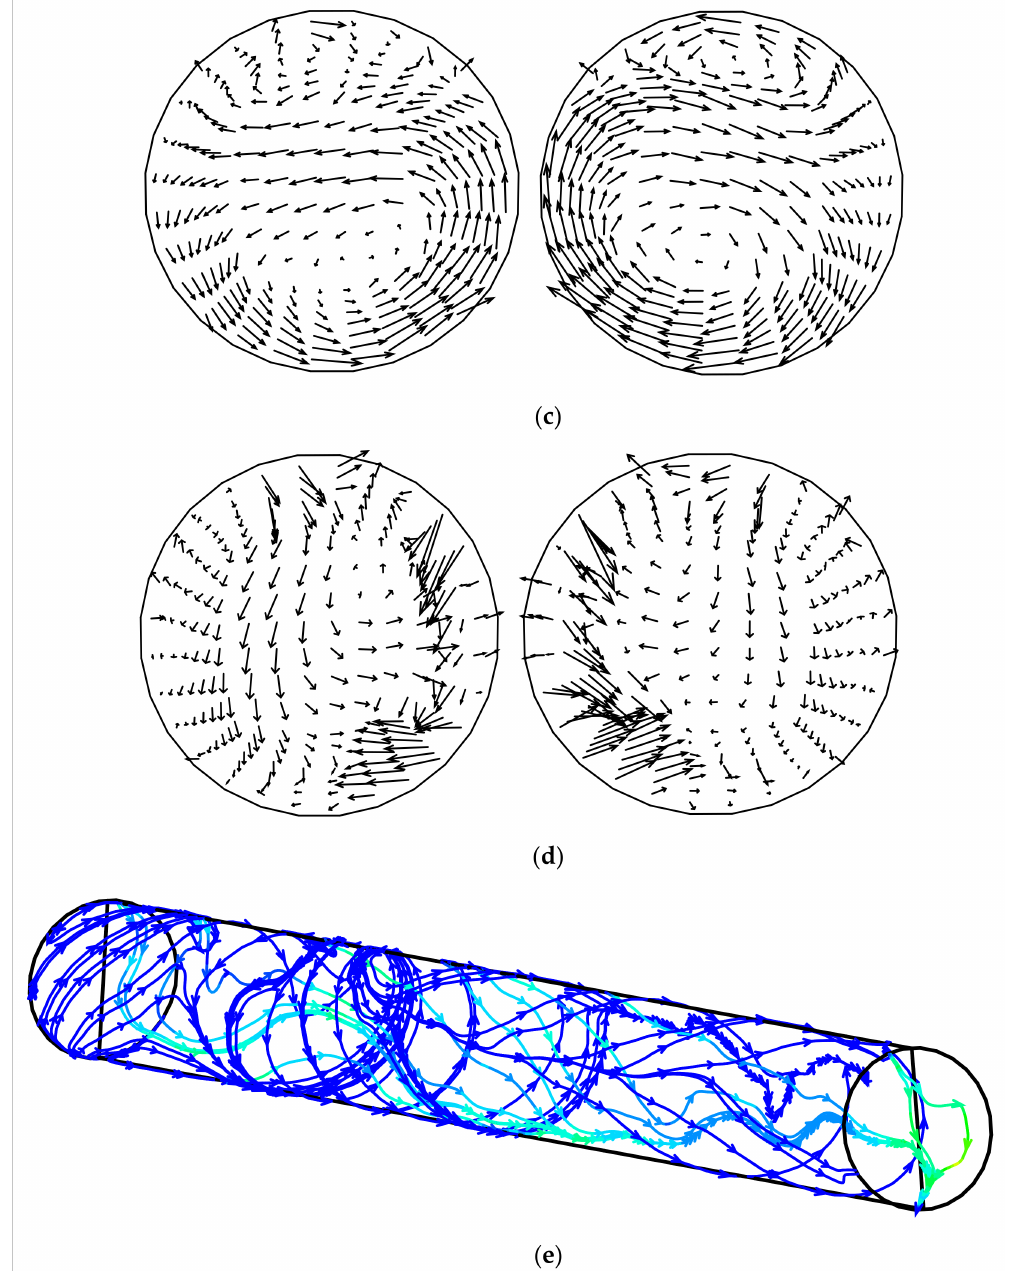
Figure 9. Flow pattern in the tundish with channel induction heating. ( a ) Streamline at vertical plane, X = − 0.379 (YZ plane); ( b ) velocity vector in the inlet of channel, Y = 0.775 (XZ plane); ( c ) velocity vector in the middle of channel, Y = 1.635 (XZ plane); ( d ) velocity vector in the outlet of channel, Y = 2.51 (XZ plane); ( e ) streamline in the channel, X = − 0.379 (YZ